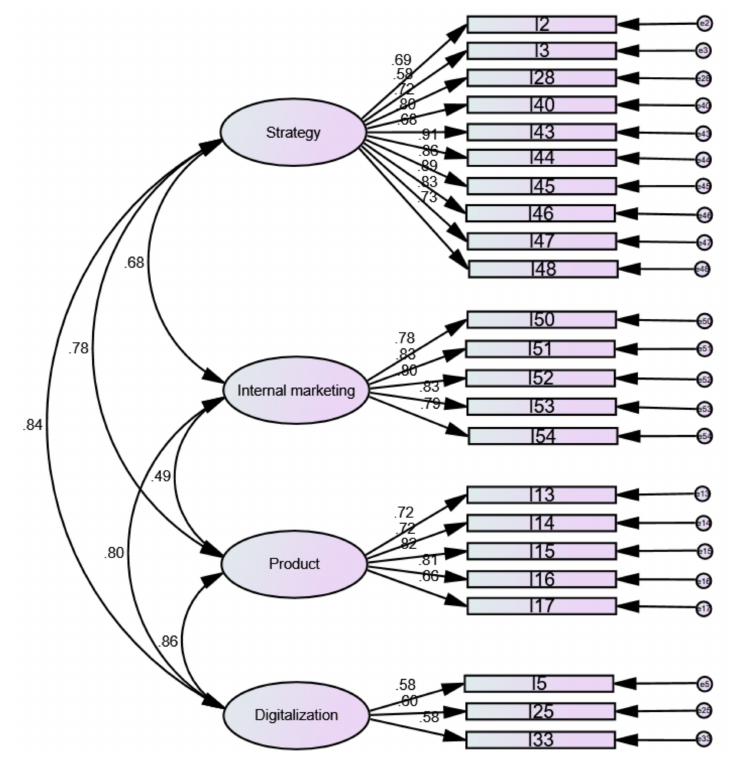
Figure 2. Model 2. The four-factor, 23 item confirmatory factor analysis (CFA) model of the Green Marketing Scale (GMaS).